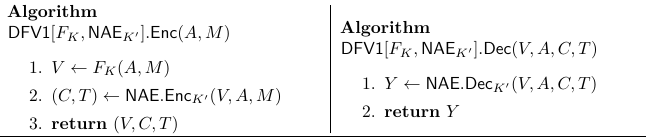
Figure 2: A generic construction DFV1 . The function F : K×A×M → V is a vector-input PRF, NAE = ( NAE . Enc , NAE . Dec ) is a non-plain NAE scheme with a key space K 0 , a nonce space V = { 0 , 1 } ν , an AD space A , a message space M and a tag space T